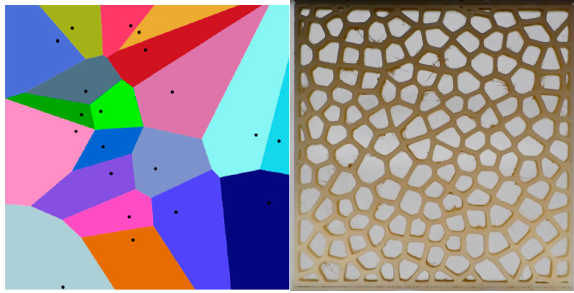
Figure 10. Voronoi diagram (left, Attribution: Wikimedia Commons, Balu Ertl), and 3D printed Voronoi prismatic structure.